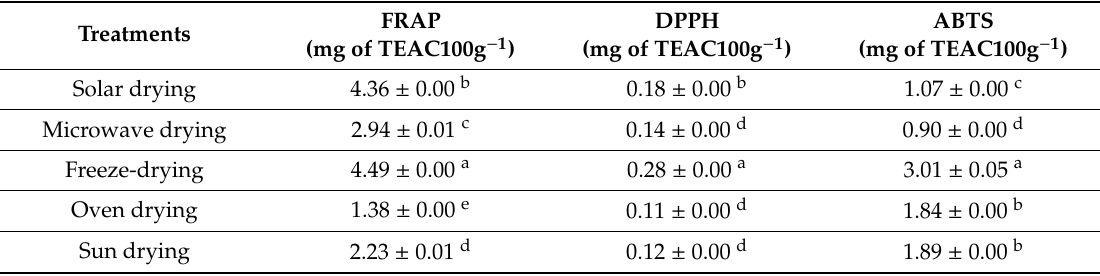
Table 11. E ff ects of di ff erent postharvest drying methods on antioxidant activities in Chinese cabbage. Treatments